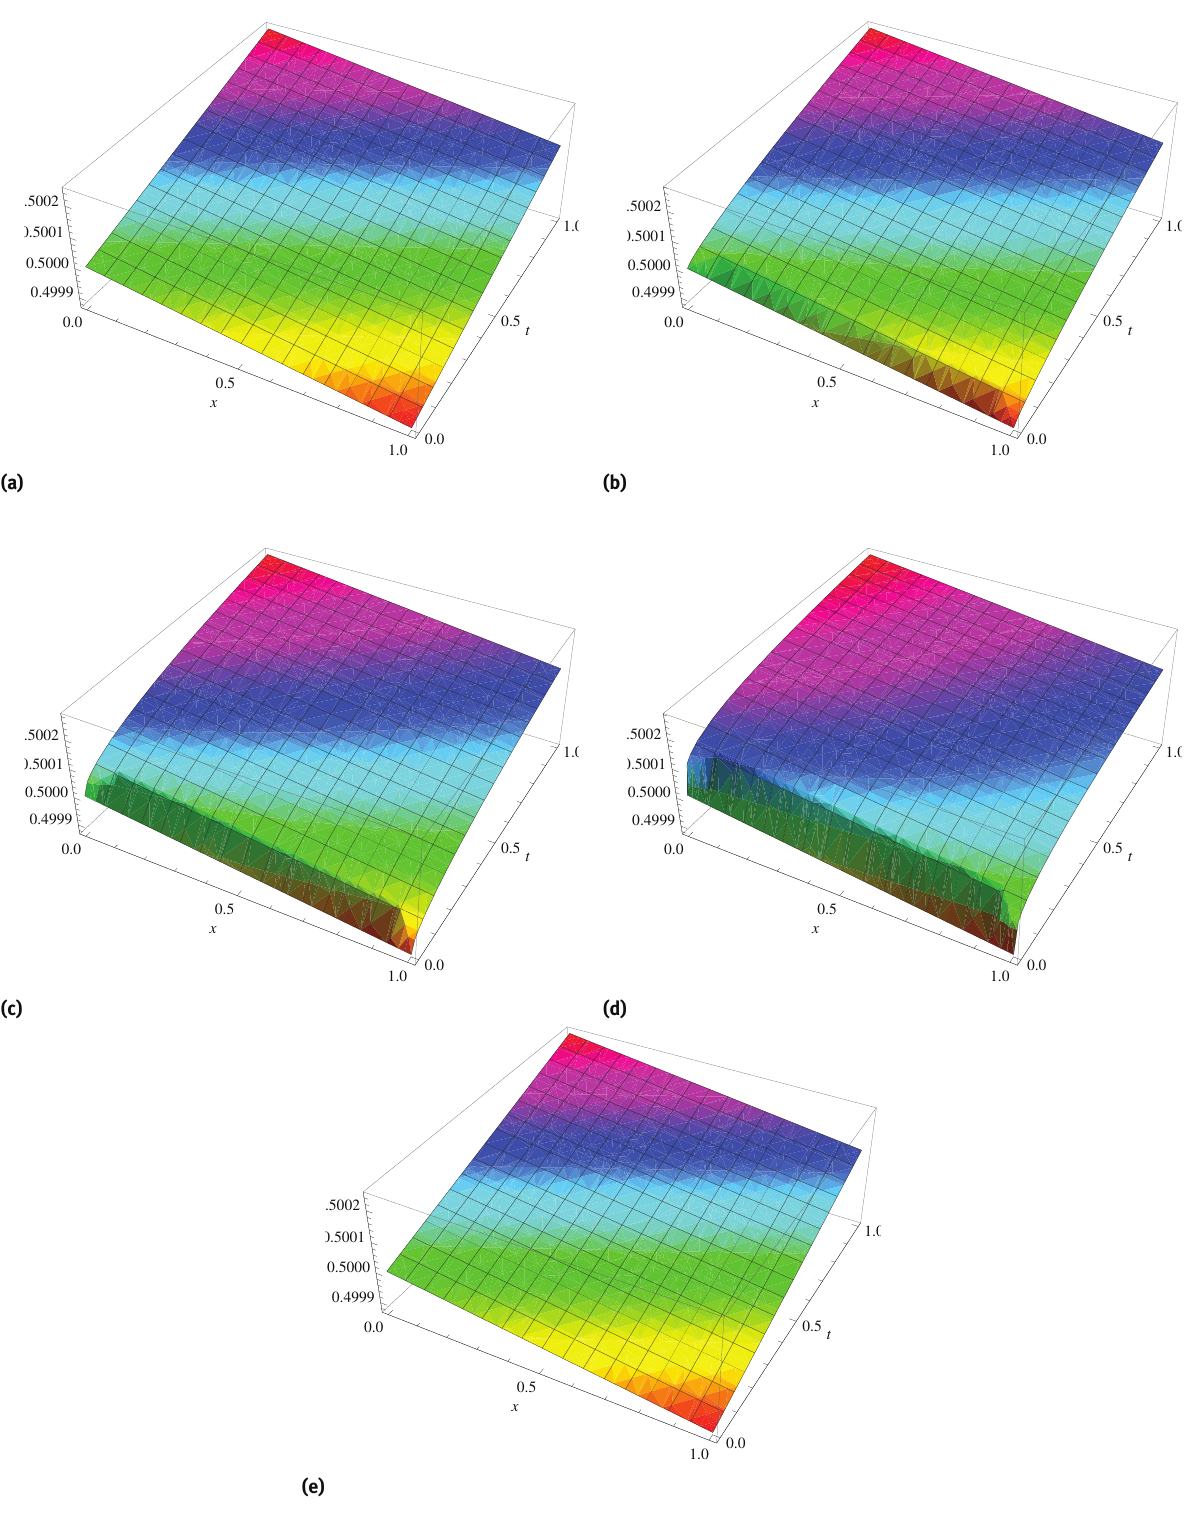
Fig. 3: Surface shows the 3rd order approximate solution of the time- fractional generalized B-F equation: (a) u 3 ( x , t ) when α = 1 , (b) u 3 ( x , t ) when α = 0.75 , (c) u 3 ( x , t ) when α = 0.5 , (d) u 3 ( x , t ) when α = 0.25 , (e) exact solution u ( x , t ) when α = 1